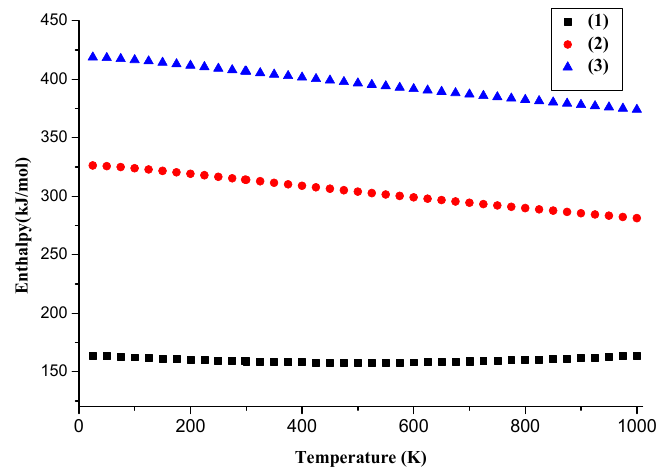
Figure 9. The reaction energy of decomposition paths with temperature.